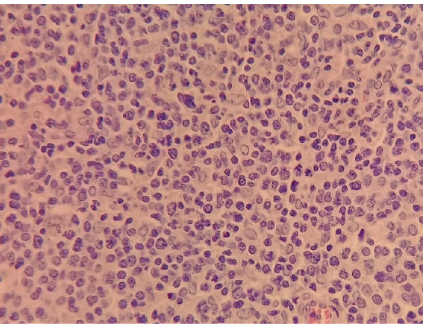
Figure 3: Cytology of pediatric ovarian lymphoma: diffuse large B- cell lymphoma (40x).